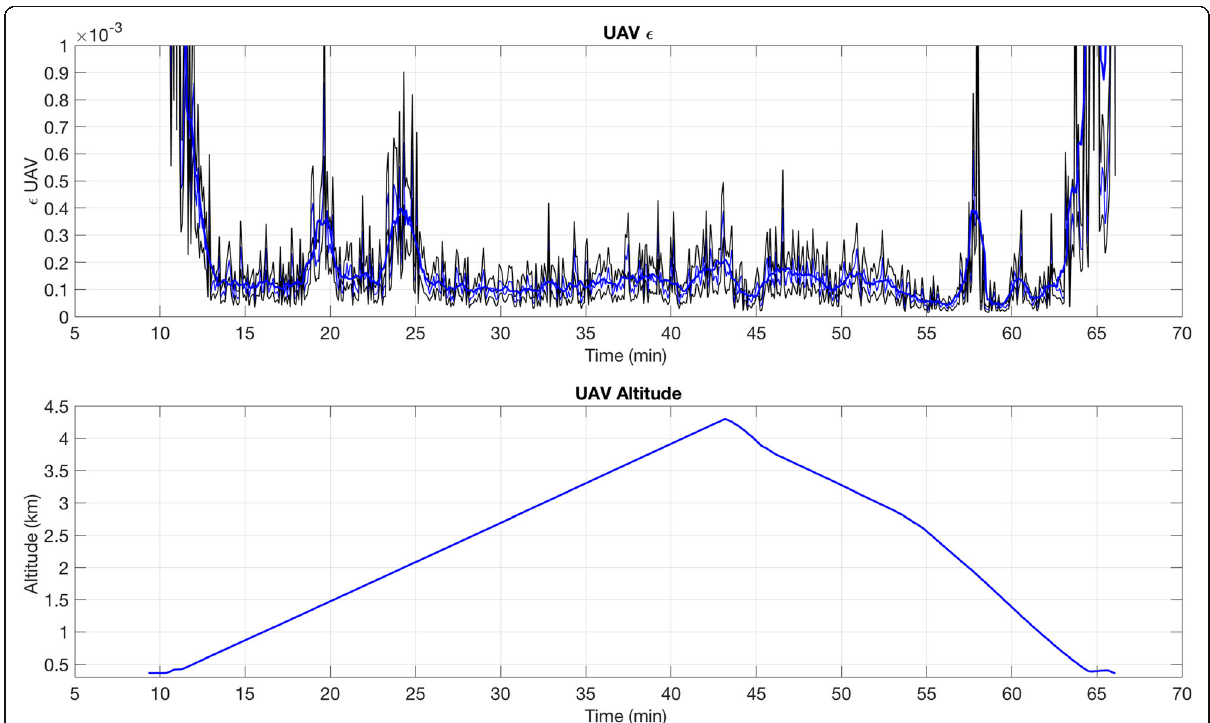
Fig. 12 ( Top panel ) ε UAV values (W kg − 1 ) plotted as a function of time for UAV 5. Thin blue line shows the mean values, whereas thick blue line shows the 11-point (55 s) running mean values. The thin black lines are the upper and lower bounds on the ε UAV estimate. ( Bottom panel ) UAV altitude as a function of